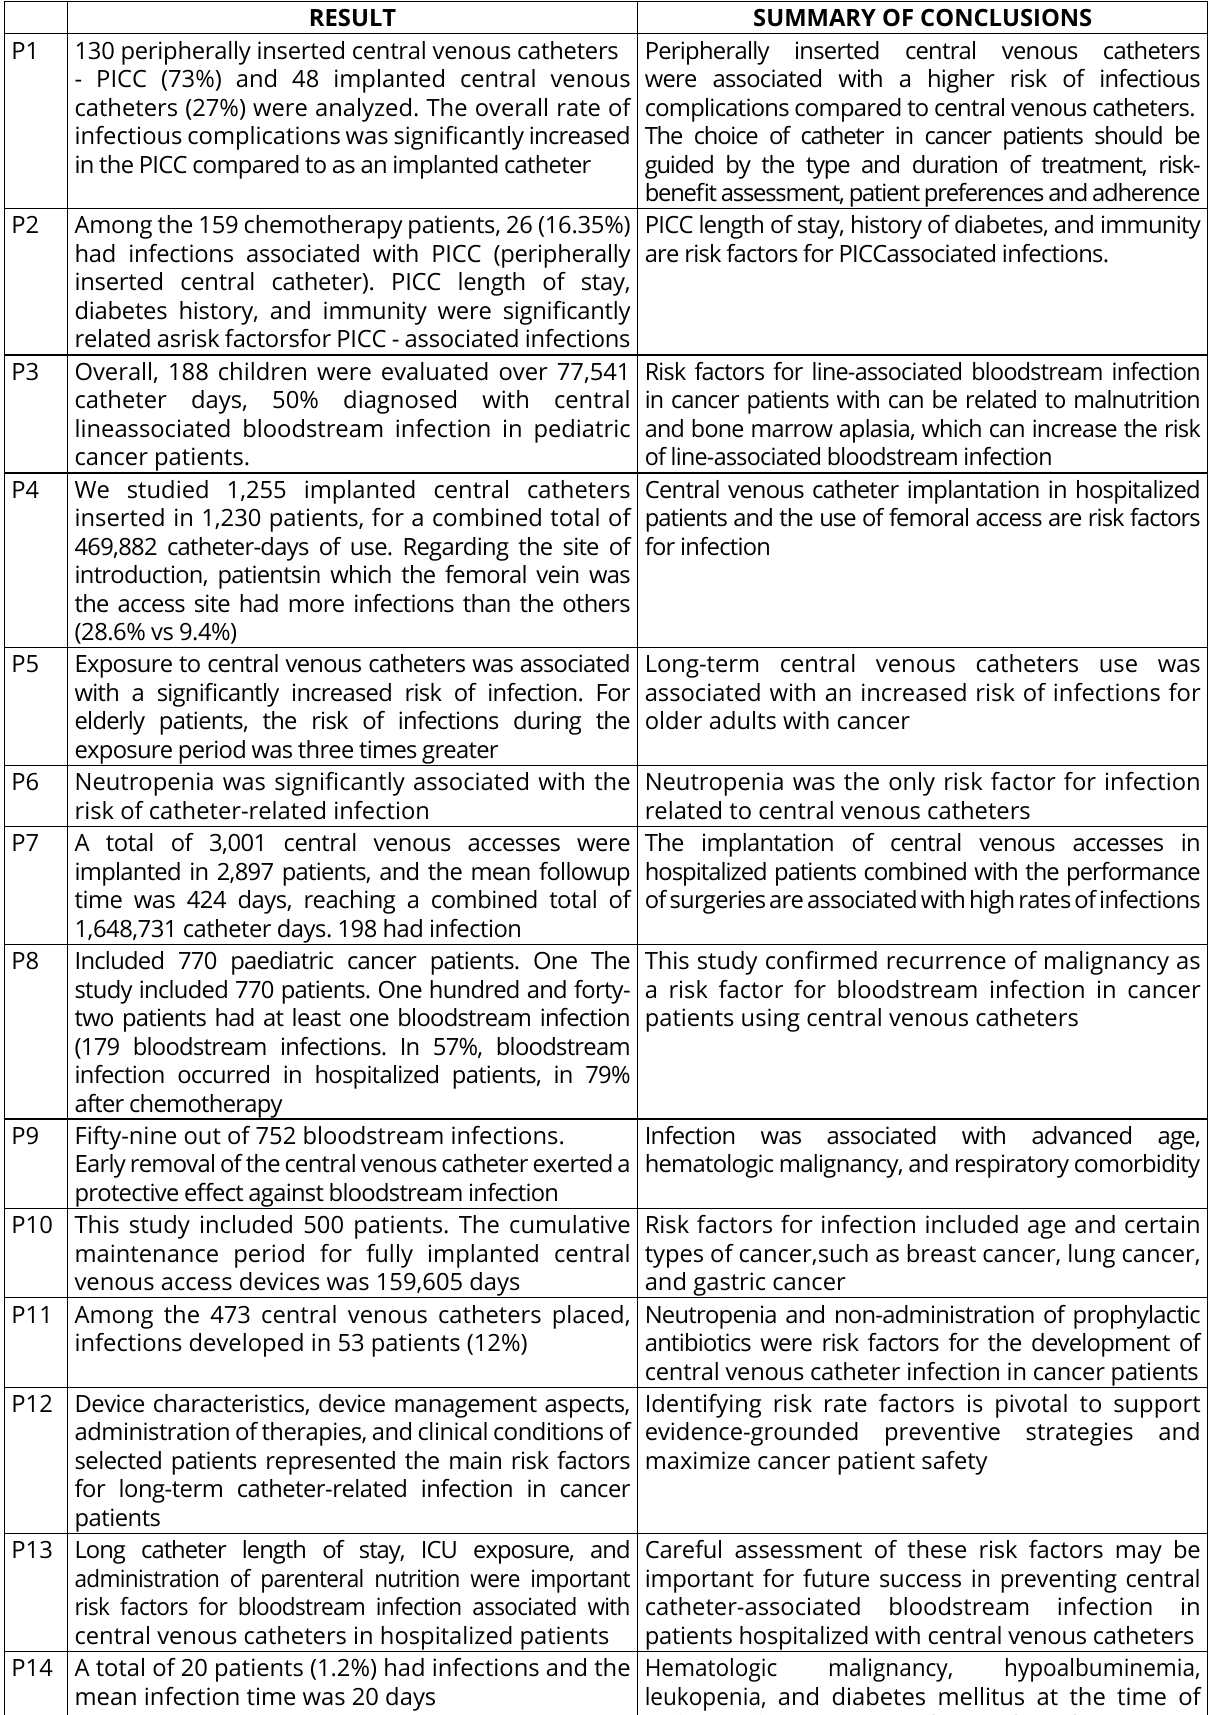
Table 2. Summarized description of the main results and conclusions of each study.